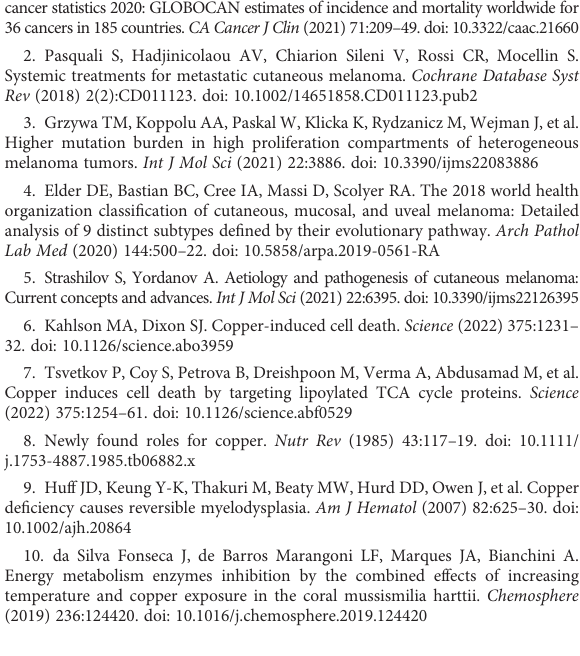
SUPPLEMENTARY FILE 1 98 drugs were with signi fi cant differences in IC50 concentrations between high and low risk